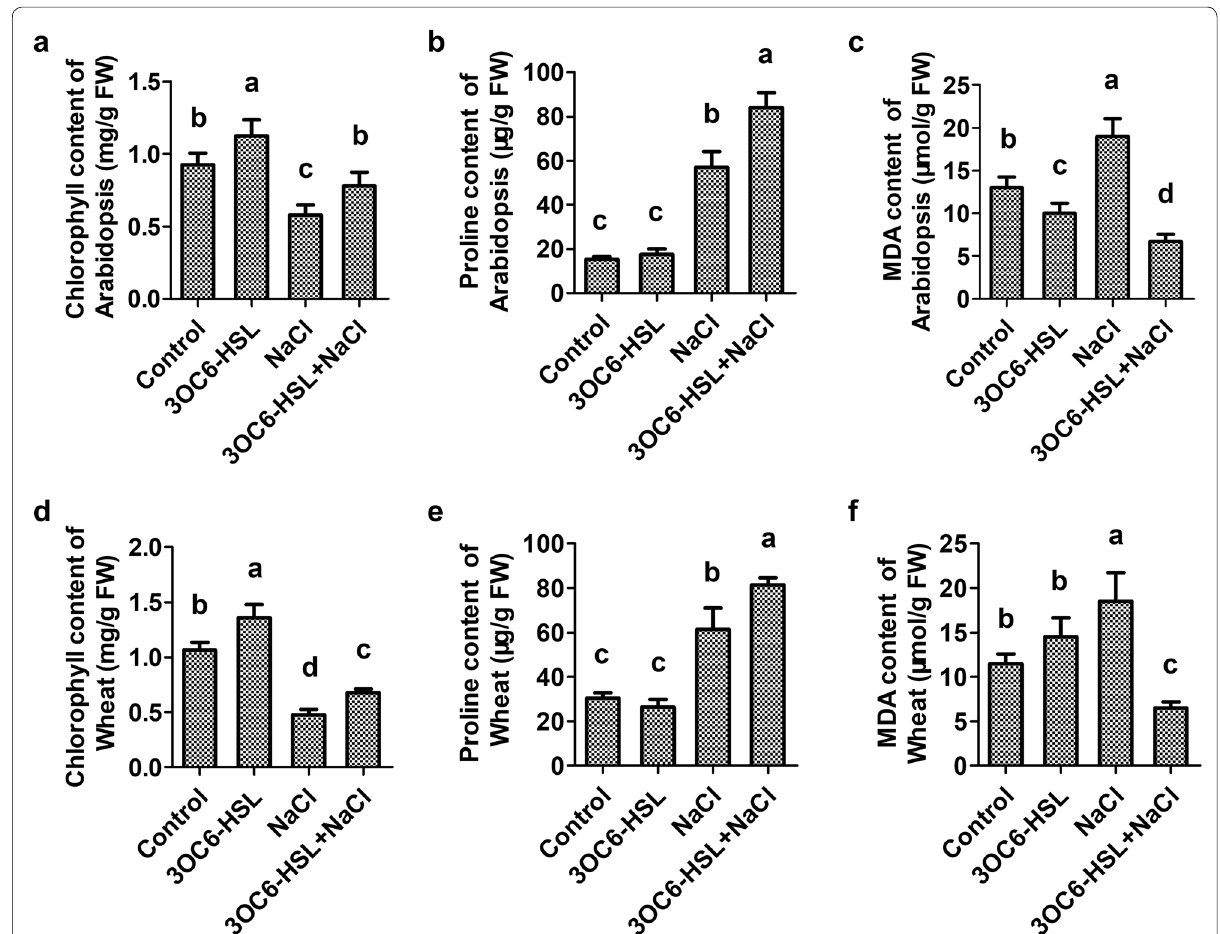
Fig. 3 Effect of 3OC6‑HSL on biochemical markers related to salt toleranc in Arabidopsis and wheat. 2‑week‑old seedlings were treated with 1 μM 3OC6‑HSL or/and 150 mM NaCl as indications. The levels of total chorophyll, proline and MDA were measured after treatment for 14 days in Arabidopsis ( a – c ) and 10 days in wheat ( d – f ). Values are mean SD of three independent experiments. Different letters indicate statistically ± significant differences ( P < 0.05, Duncan’s